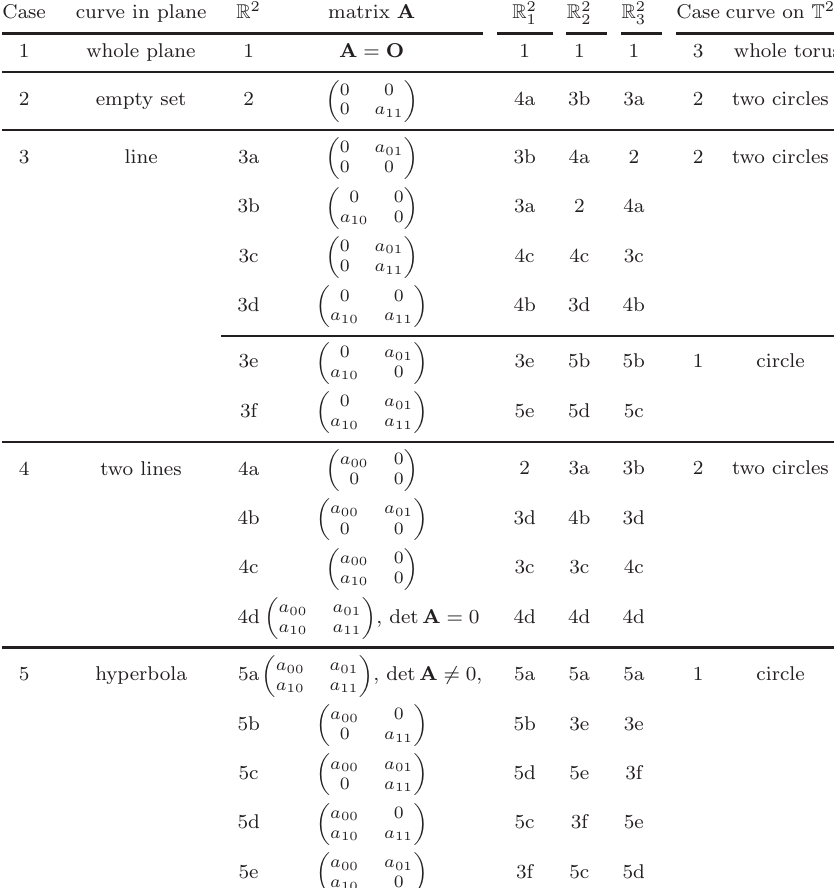
Table 1. Classification of the Characteristic